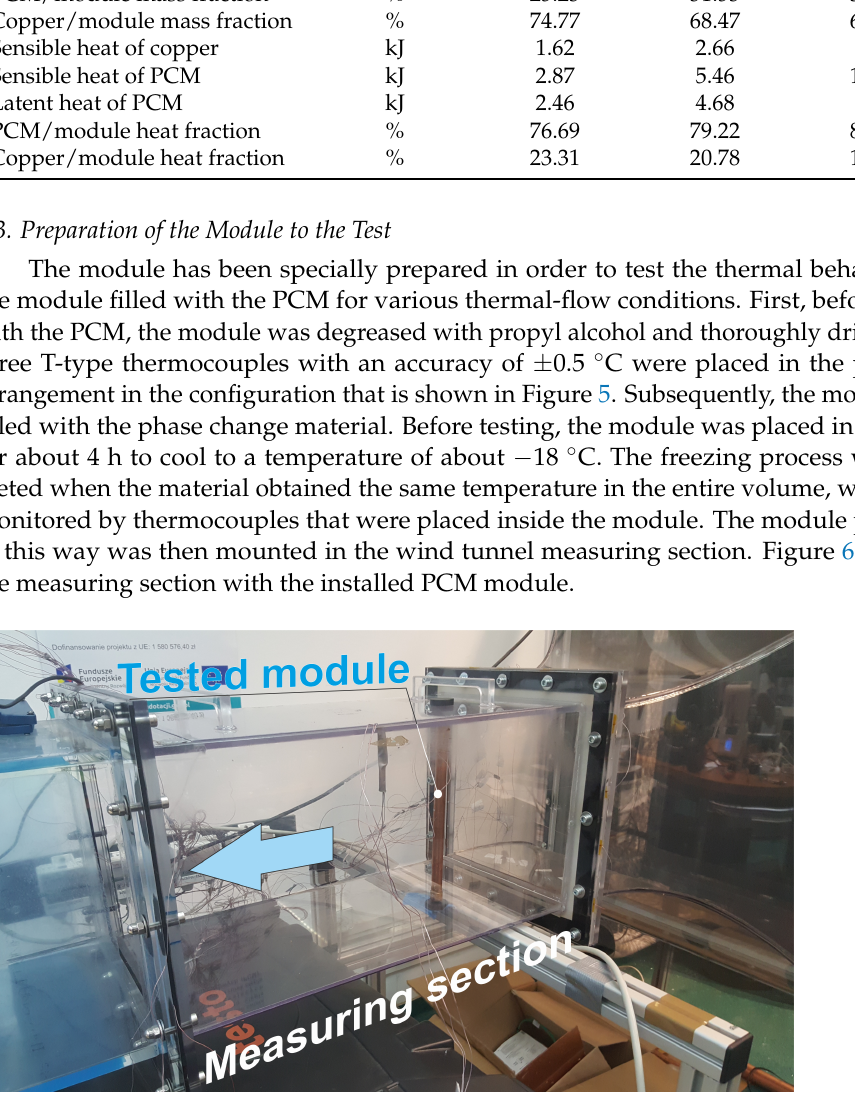
Figure 6. PCM module placed in the wind